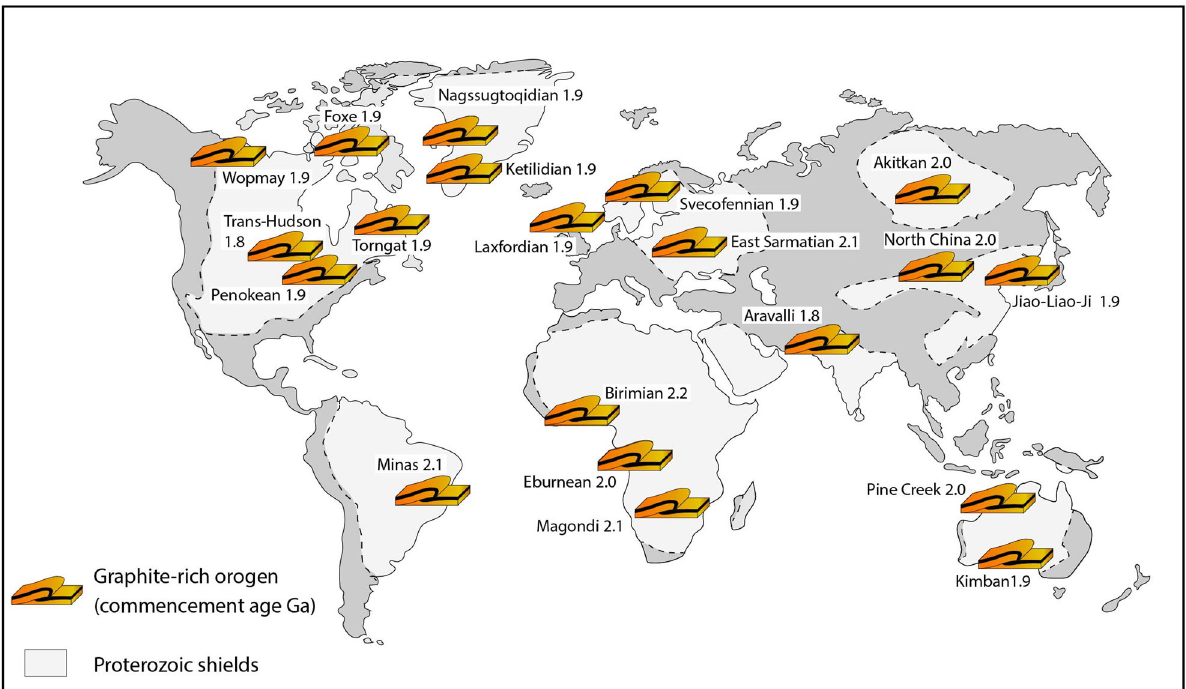
Fig. 1 Palaeoproterozoic orogens, distributed globally, exhibiting signi fi cant deformation within highly carbonaceous rocks. Orogenies all commenced 2.2 to 1.8 Ga. Details in Table 1. Orogens shown relative to distribution of Proterozoic shields 47